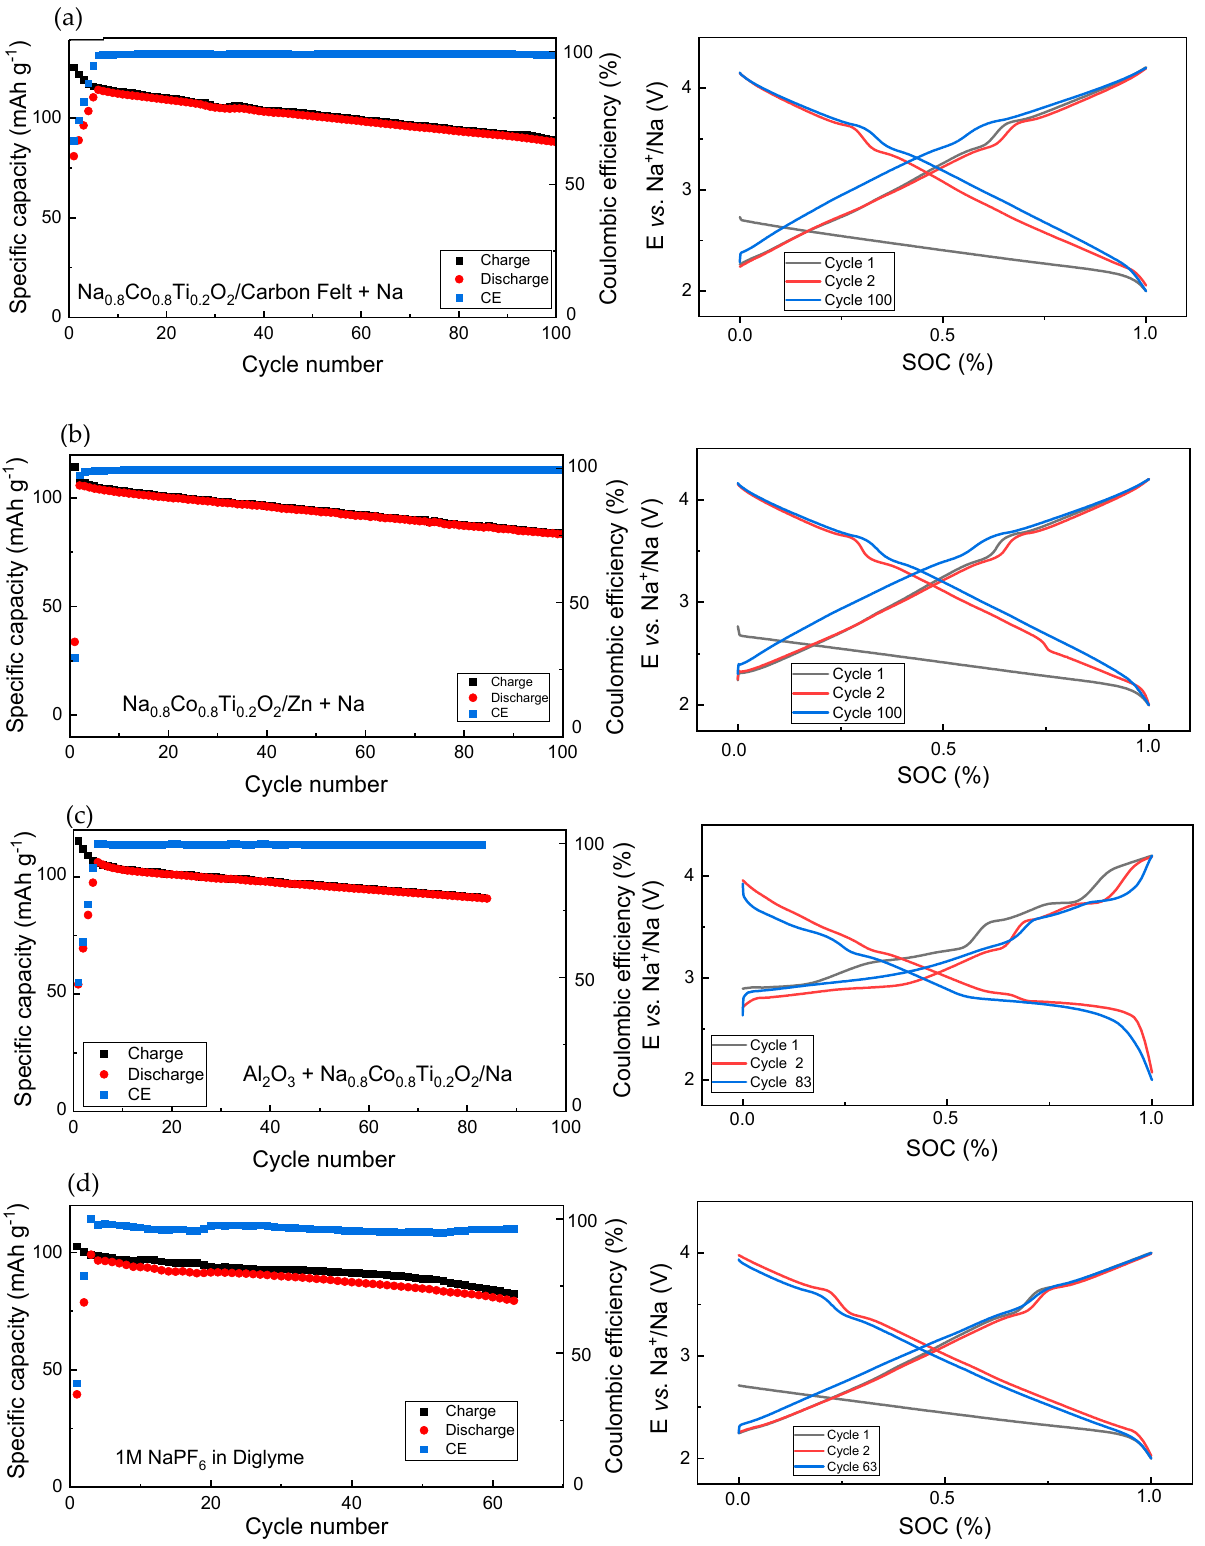
Figure 5. Electrochemical properties of cells with protective measures for the cathode and anode side. ( a ) A cell with carbon felt as a protective layer on the Na metal anode, ( b ) a cell with a protective Zn-coating on the Na metal anode, ( c ) a cell with a protective Al 2 O 3 coating on the Na 0.8 Co 0.8 Ti 0.2 O 2 cathode, and ( d ) a cell with 1M NaPF 6 in Diglyme as electrolyte.